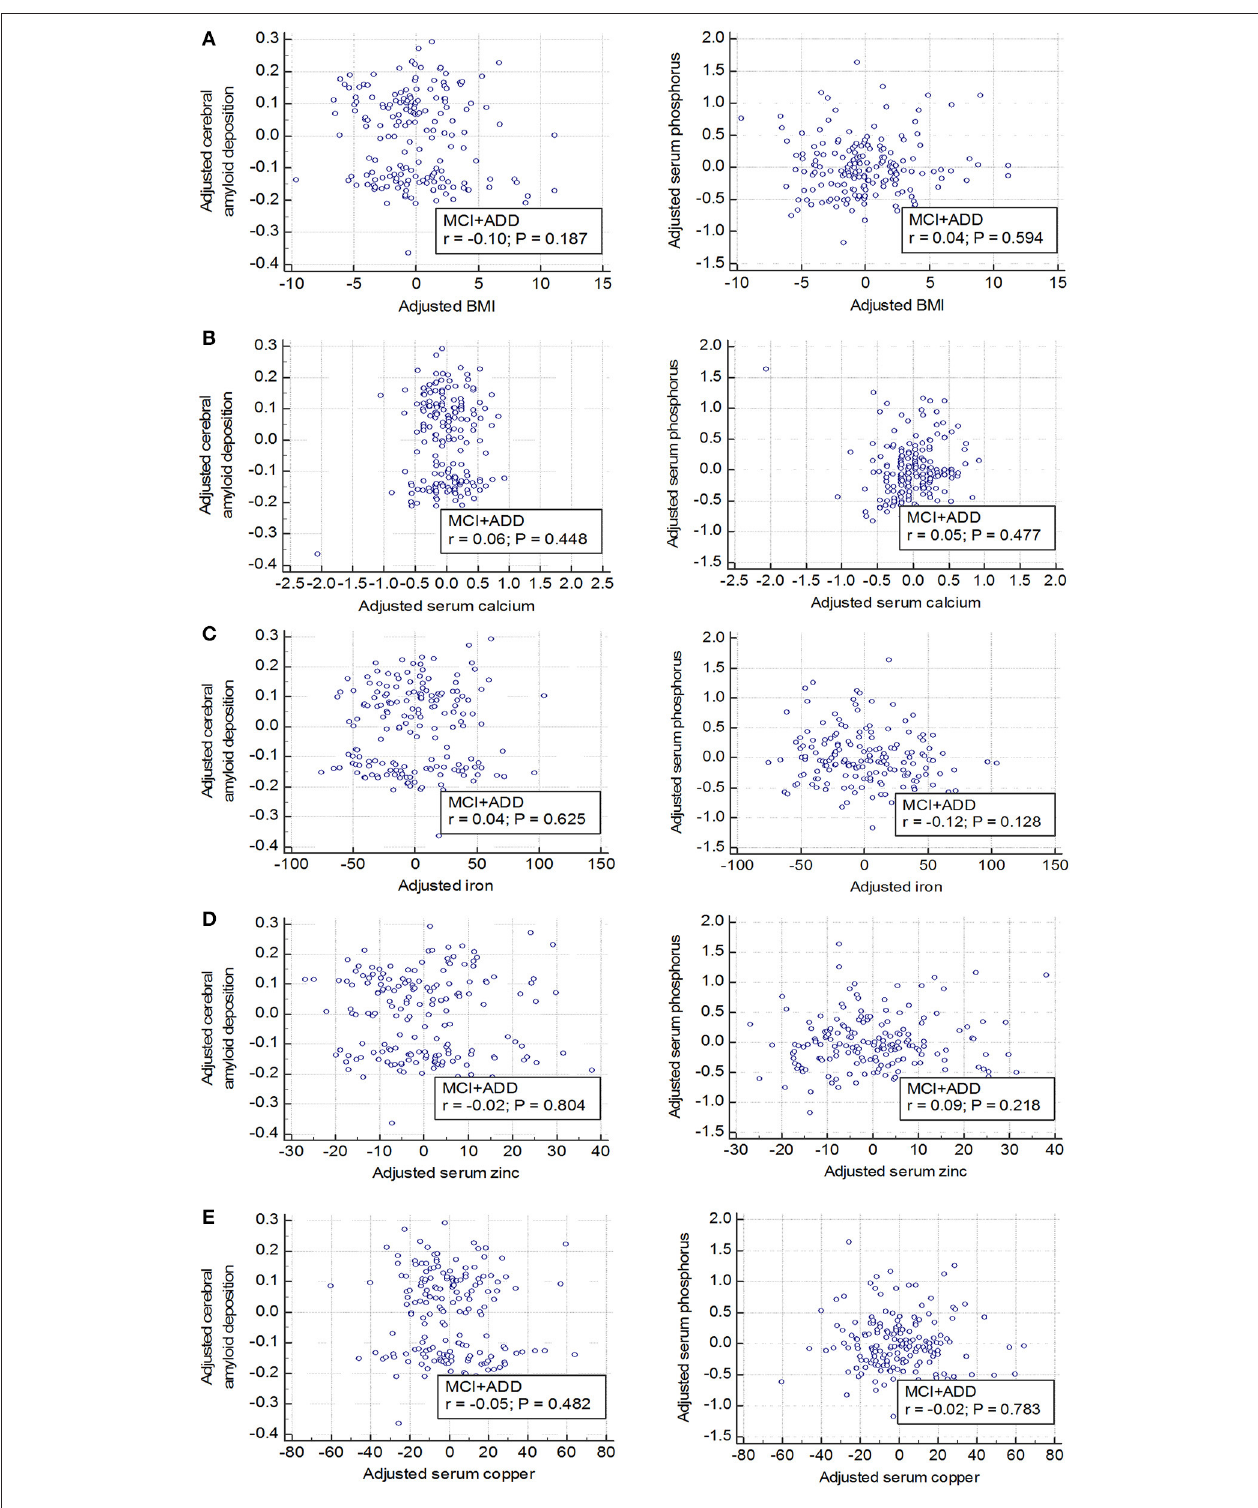
FIGURE 3 | No relationship between elements and body mass index (BMI) and brain A β deposition or serum phosphorus (A–E) Elements (calcium, iron, zinc, and copper) and an indicator (BMI) which can reflect the health conditions are not associated with both cerebral amyloid deposition (left graphs) and serum phosphorus levels (right graphs). Age and sex were adjusted and global cerebral amyloid burden (SUVR) was natural log transformed to normalize variance. MCI, mild cognitive impairment; ADD, Alzheimer’s disease dementia; SUVR, standardized uptake value ratio.